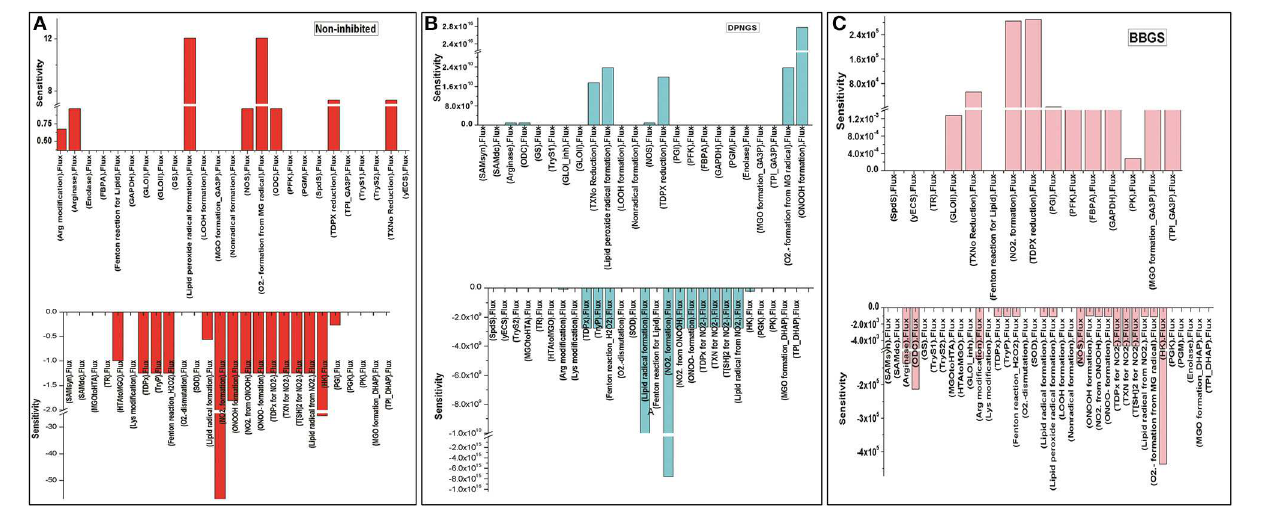
FIGURE 11 | Illustration of Sensitivity analysis of kinetic models. For sensitivity analyses in these models, Vmax of GLO I was used to observe its influence on the flux of other reactions, (A) non-inhibited model; (B) BBGS inhibited model; (C) DNPGS inhibited